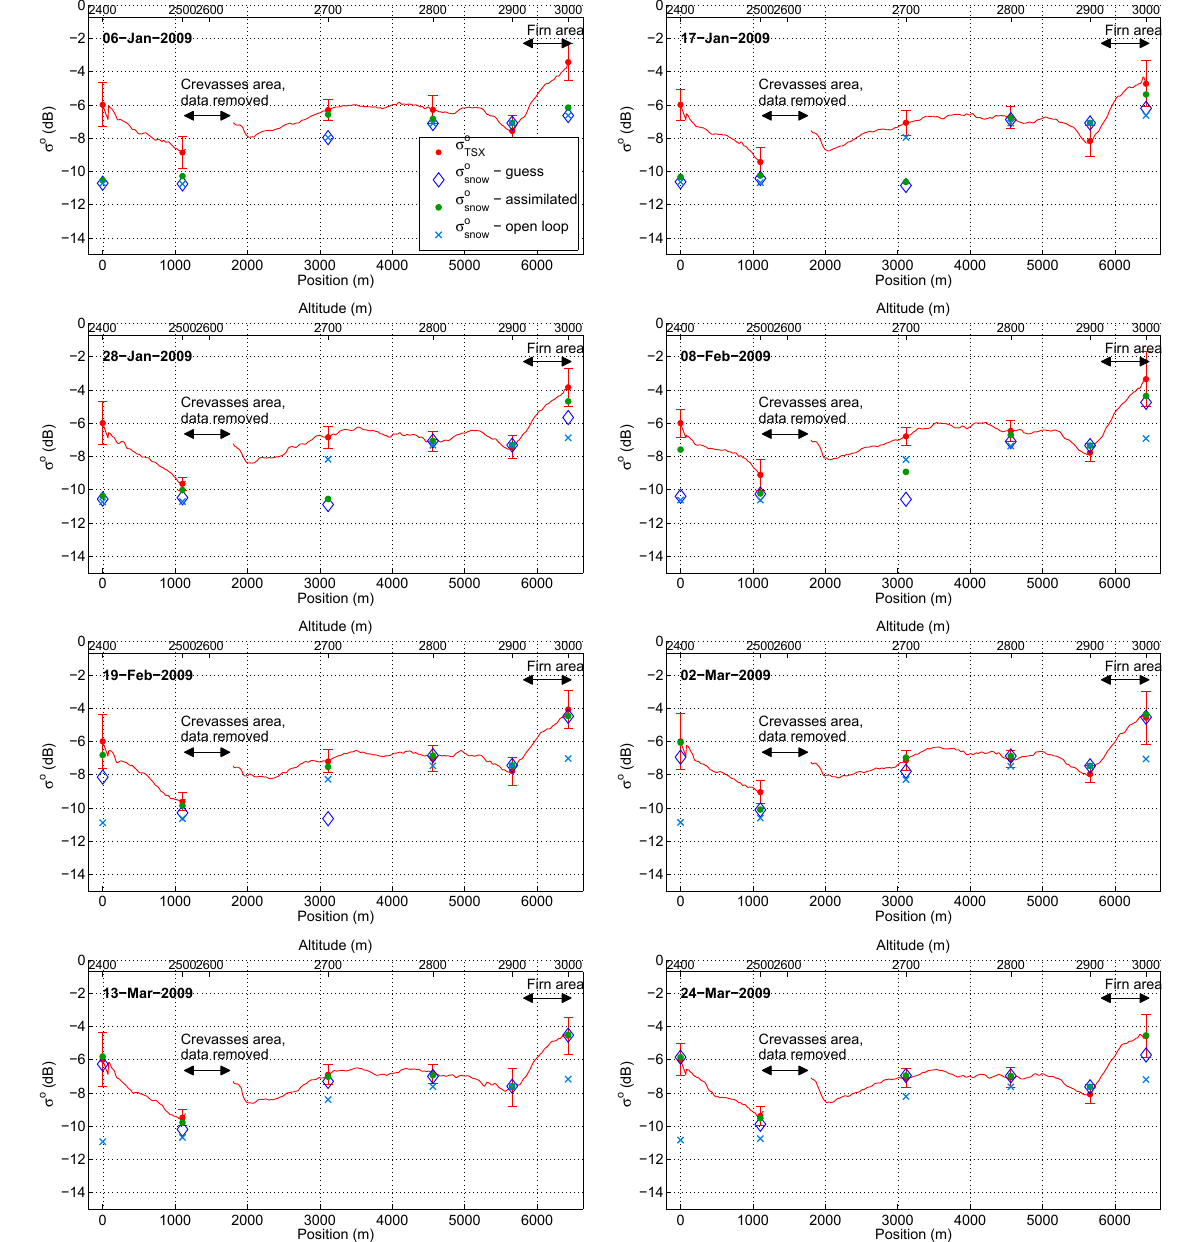
Figure 9. Results of simulation and analysis using eight TerraSAR-X acquisitions performed in winter 2009. σ TSX (red) are mean values obtained from the SAR images over the Argentière glacier (corresponding to the red line of Fig. 5). σ sim (blue) represents the output of simulations using Crocus snowpack variables as inputs. Simulations obtained after data analysis are shown in green. Error bars show the standard deviation of the measured